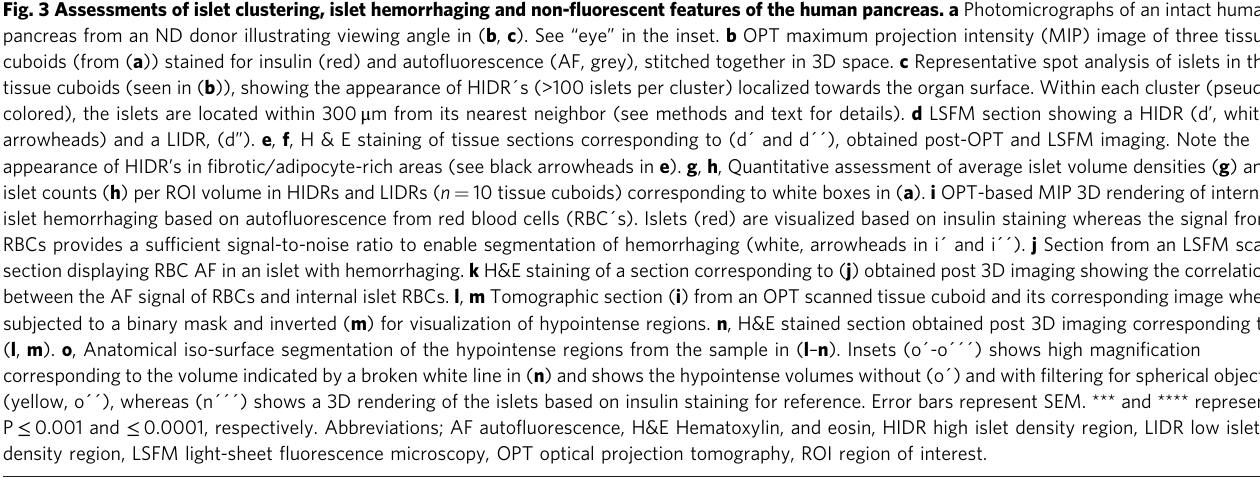
Fig. 3 Assessments of islet clustering, islet hemorrhaging and non- fl uorescent features of the human pancreas. a Photomicrographs of an intact human pancreas from an ND donor illustrating viewing angle in ( b , c ). See “ eye ” in the inset. b OPT maximum projection intensity (MIP) image of three tissue cuboids (from ( a )) stained for insulin (red) and auto fl uorescence (AF, grey), stitched together in 3D space. c Representative spot analysis of islets in the tissue cuboids (seen in ( b )), showing the appearance of HIDR´s (>100 islets per cluster) localized towards the organ surface. Within each cluster (pseudo colored), the islets are located within 300 μ m from its nearest neighbor (see methods and text for details). d LSFM section showing a HIDR (d ’ , white arrowheads) and a LIDR, (d ” ). e , f , H & E staining of tissue sections corresponding to (d´ and d´´), obtained post-OPT and LSFM imaging. Note the appearance of HIDR ’ s in fi brotic/adipocyte-rich areas (see black arrowheads in e ). g , h , Quantitative assessment of average islet volume densities ( g ) and islet counts ( h ) per ROI volume in HIDRs and LIDRs ( n = 10 tissue cuboids) corresponding to white boxes in ( a ). i OPT-based MIP 3D rendering of internal islet hemorrhaging based on auto fl uorescence from red blood cells (RBC´s). Islets (red) are visualized based on insulin staining whereas the signal from RBCs provides a suf fi cient signal-to-noise ratio to enable segmentation of hemorrhaging (white, arrowheads in i´ and i´´). j Section from an LSFM scan section displaying RBC AF in an islet with hemorrhaging. k H&E staining of a section corresponding to ( j ) obtained post 3D imaging showing the correlation between the AF signal of RBCs and internal islet RBCs. l , m Tomographic section ( i ) from an OPT scanned tissue cuboid and its corresponding image when subjected to a binary mask and inverted ( m ) for visualization of hypointense regions. n , H&E stained section obtained post 3D imaging corresponding to ( l , m ). o , Anatomical iso-surface segmentation of the hypointense regions from the sample in ( l – n ). Insets (o´-o´´´) shows high magni fi cation corresponding to the volume indicated by a broken white line in ( n ) and shows the hypointense volumes without (o´) and with fi ltering for spherical objects (yellow, o´´), whereas (n´´´) shows a 3D rendering of the islets based on insulin staining for reference. Error bars represent SEM. *** and **** represent P ≤ 0.001 and ≤ 0.0001, respectively. Abbreviations; AF auto fl uorescence, H&E Hematoxylin, and eosin, HIDR high islet density region, LIDR low